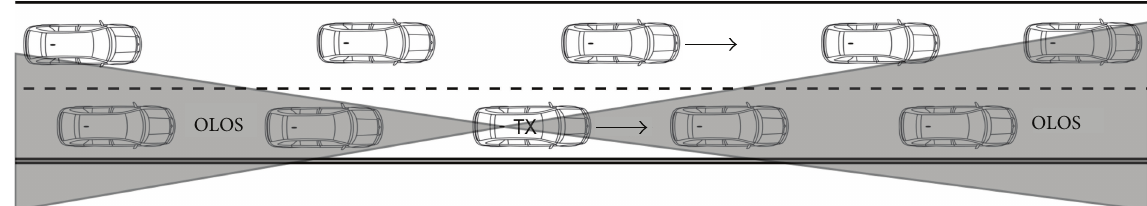
Figure 2: Identification of vehicles being in LOS and in OLOS of the TX vehicle; vehicles in the shaded-area are considered to be in OLOS whereas all other vehicles have LOS from the